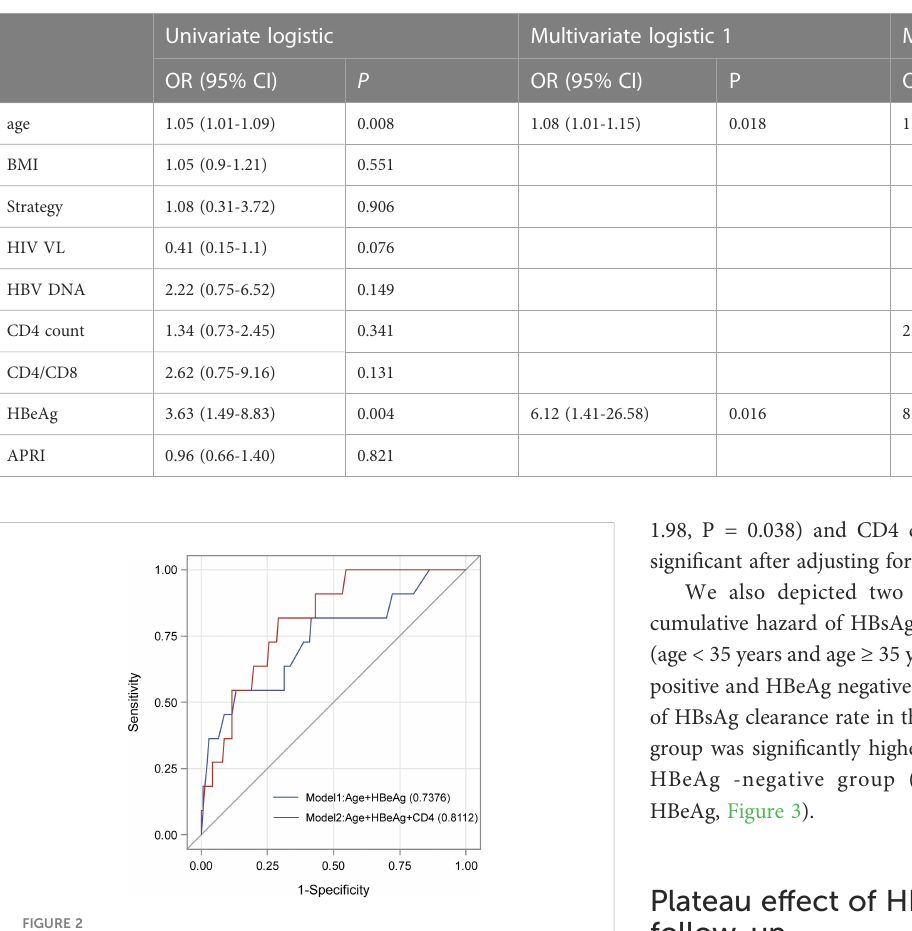
TABLE 2 Association of baseline variables with HBsAg clearance in univariate and multivariate logistic regression